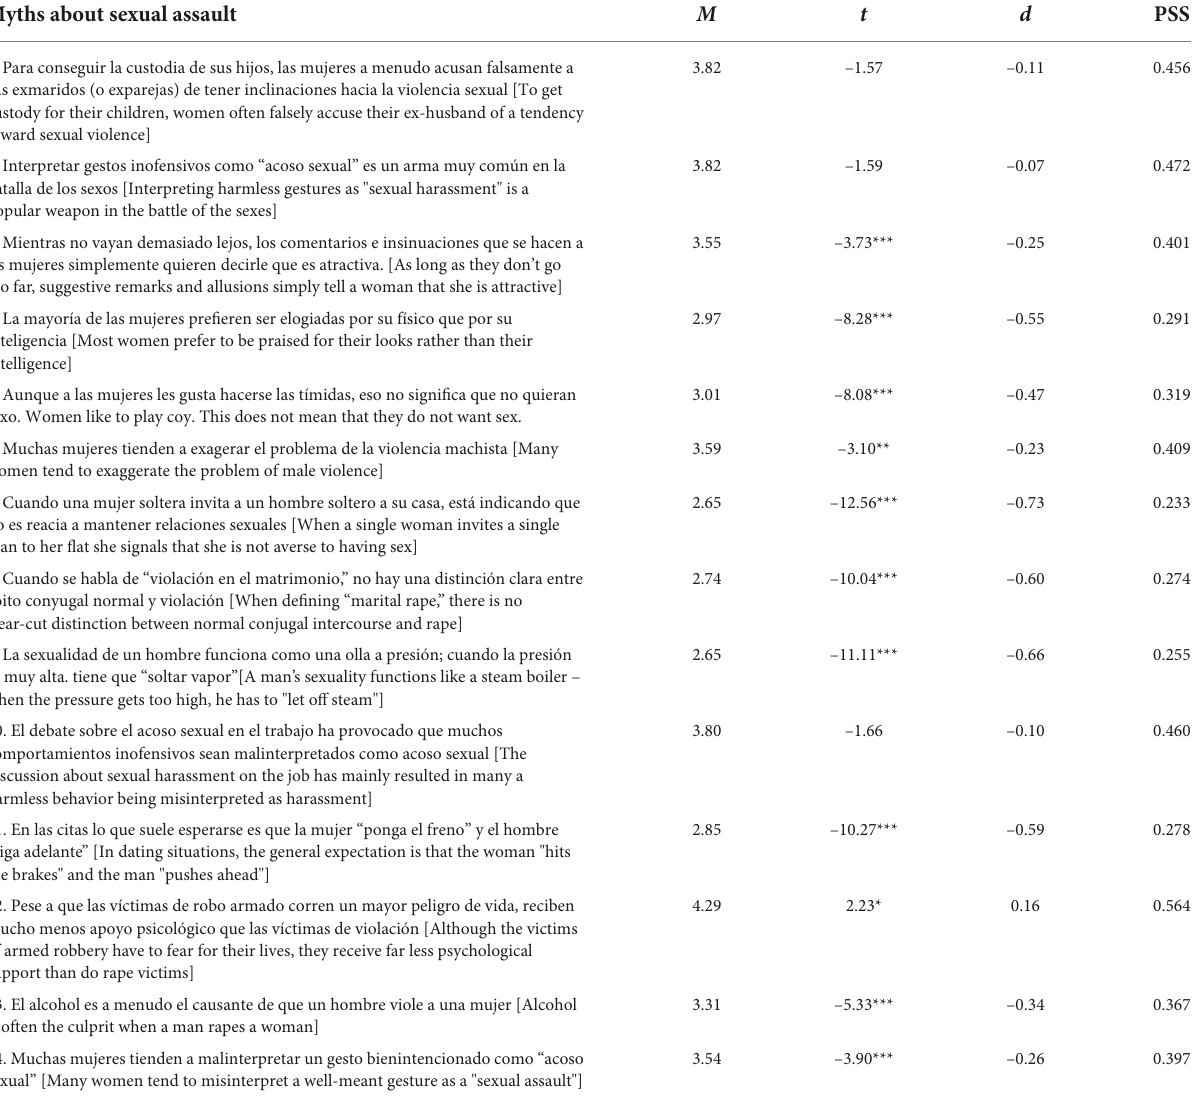
TABLE 3 One sample t -test for the contrast of the acceptance of the myths about sexual aggression (test value: 4, Neither agree nor disagree). Myths about sexual